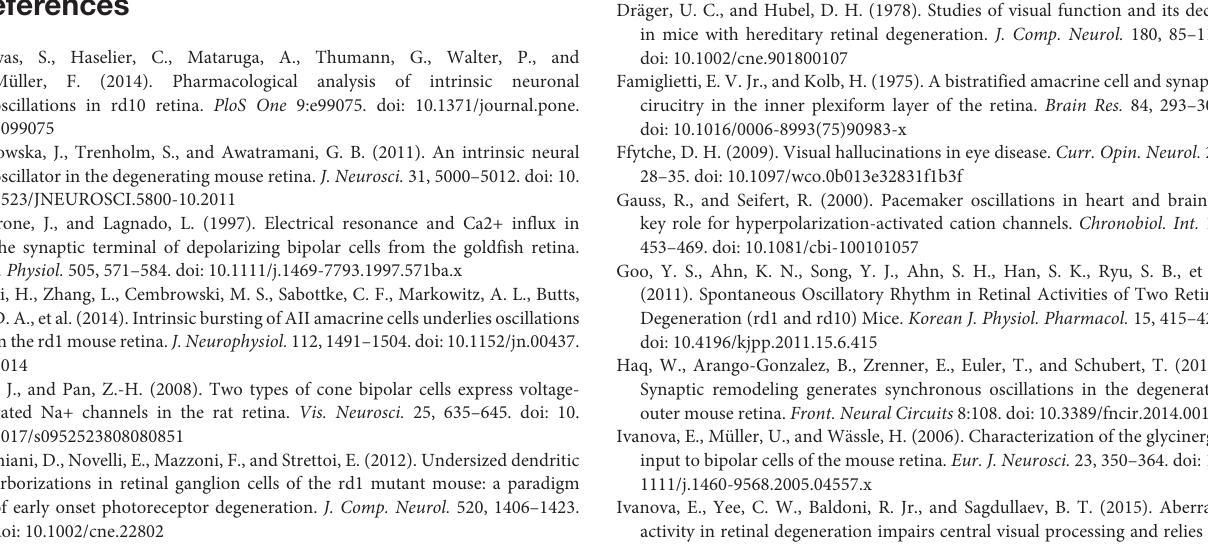
FIGURE 2 | The simplified circuit diagram for spontaneous oscillations in the rd retina. (A) A simplified circuit showing the major neuronal cell types that play a role in generating oscillations in the rd retina (adapted from Borowska et al., 2011; Margolis et al., 2014). The oscillation is an intrinsic property of the electrically coupled network of AII amacrine cells and ON cone bipolar cells (indicated with the gray box). AII amacrine cells inhibit OFF bipolar